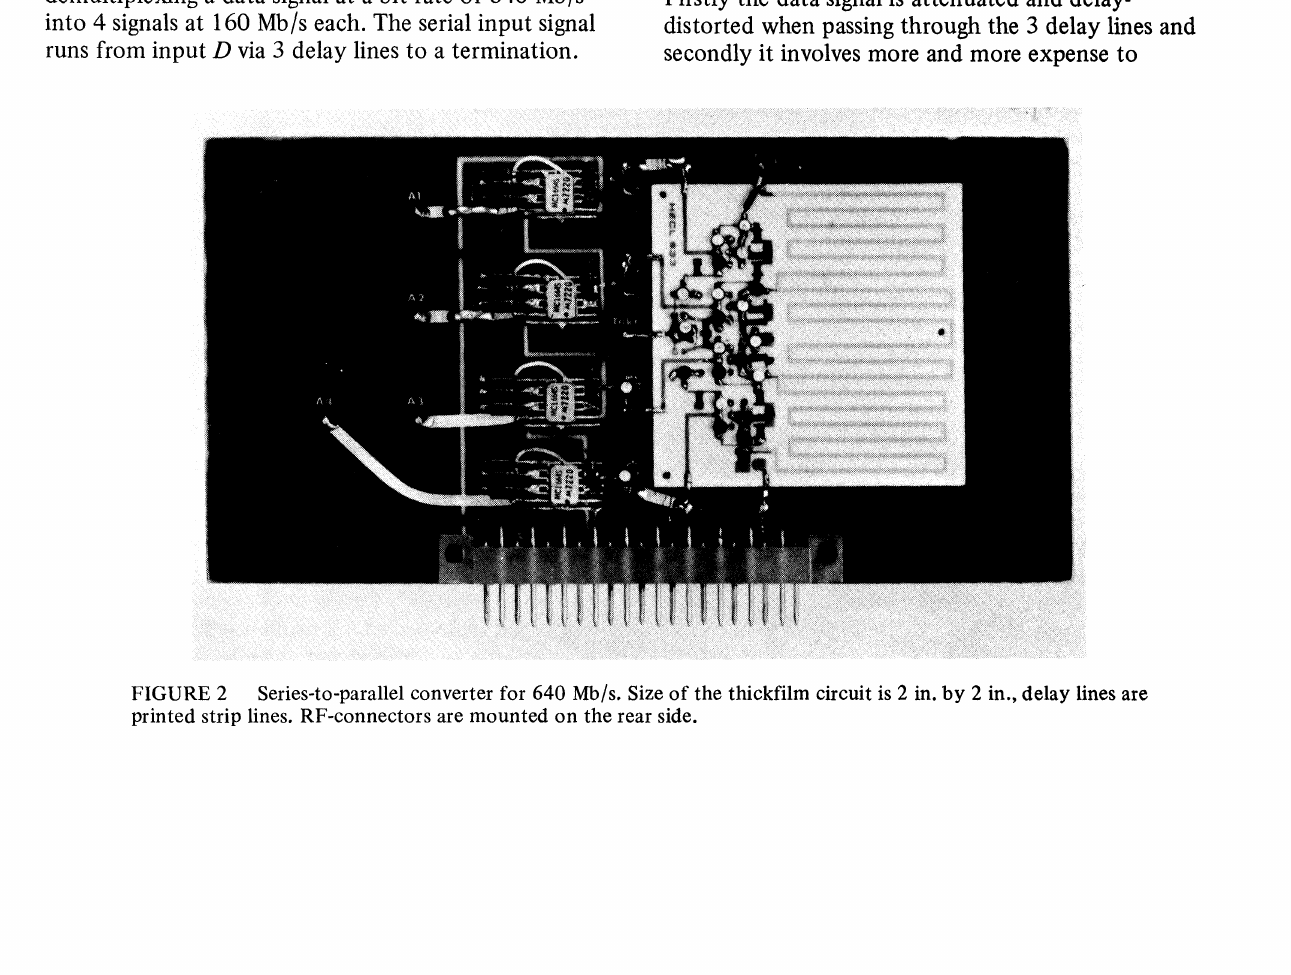
runs from input D via 3 delay lines to a termination.